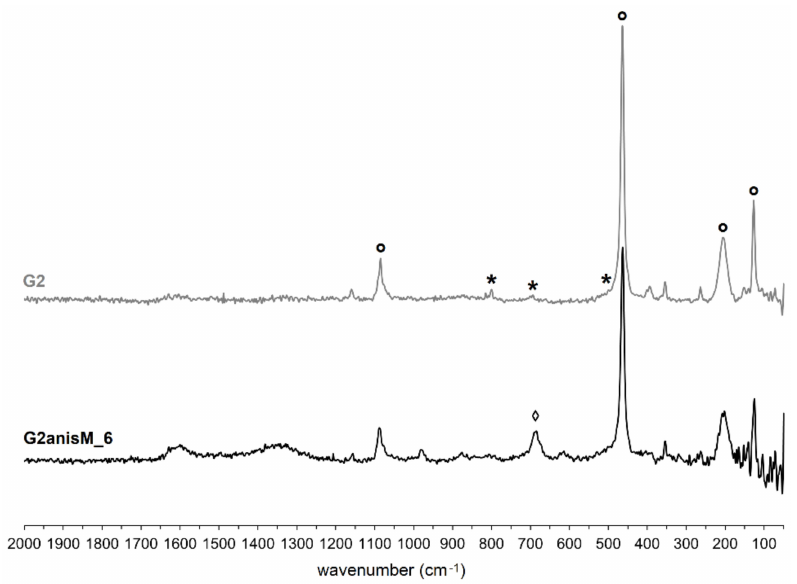
Figure 7. Raman spectra of G2 matrix and of G2anisM_6. (* = peaks relative to SiO 44 − groups; ◦ = peaks due to quartz; ♦ = peak at 688 cm − 1 due to anis-SrFe 12 O 19